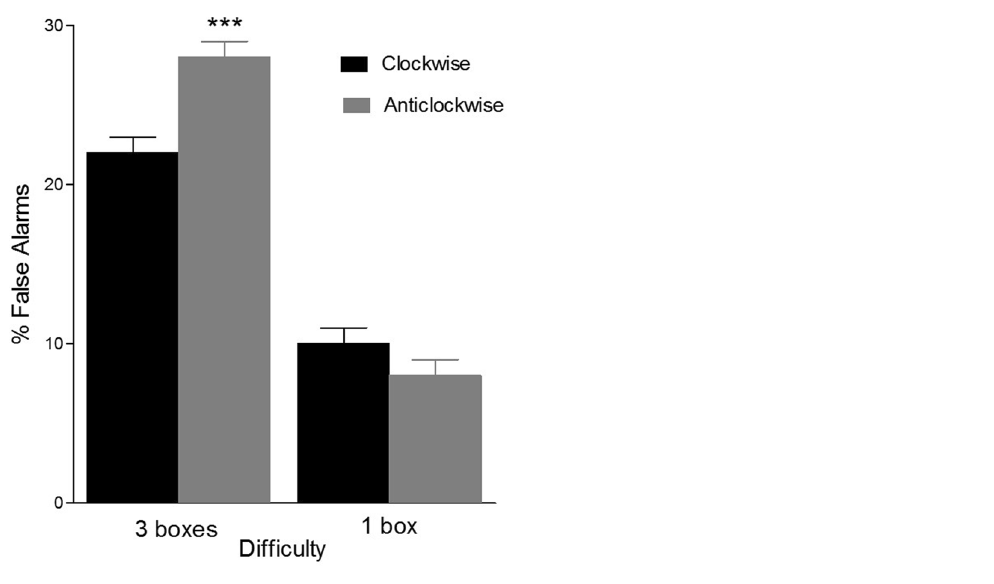
Figure 5. Mean percentage of false alarms as a function of Difficulty (one box and three boxes) and Direction (clockwise and anticlockwise). Triple asterisk means p -value <